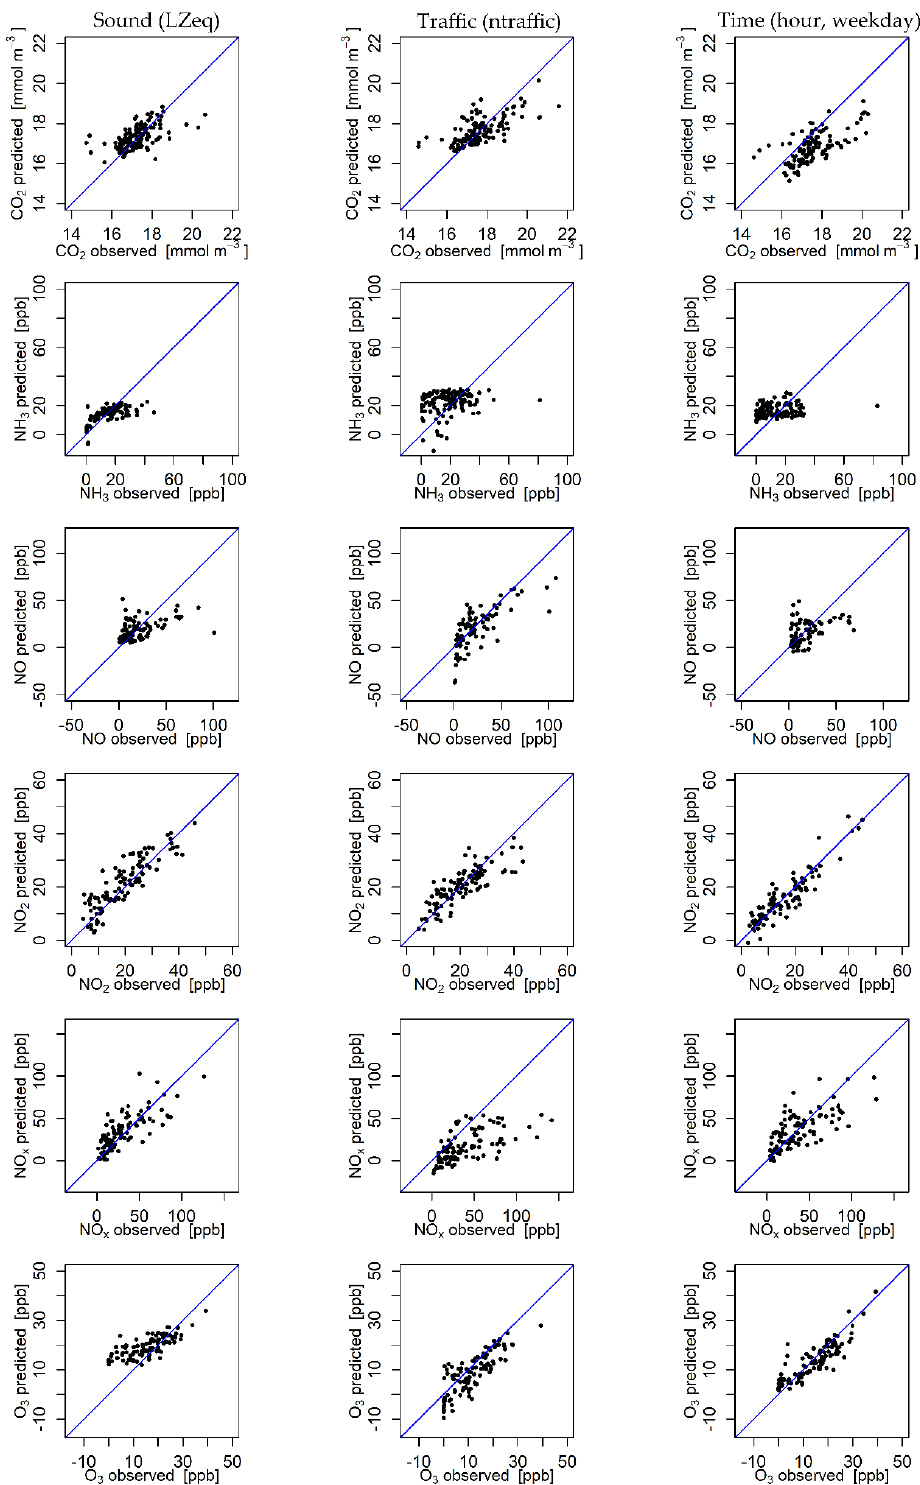
Figure 5. Scatter plot diagrams of trace gas predictions and observations for three input variable options (sound, traffic and time). The blue line illustrates a 1:1 match between the modelled and observed values.